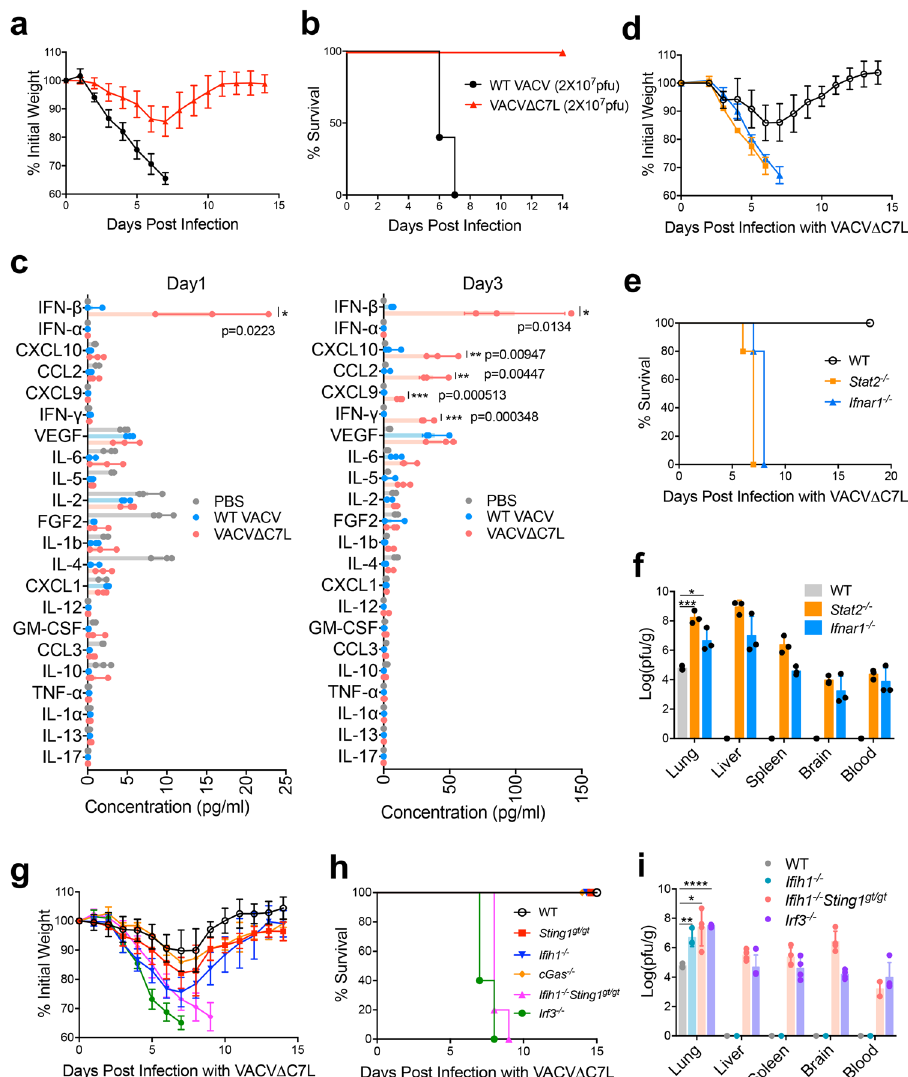
Fig. 1 Type I IFN signaling is essential for restricting replication and dissemination of vaccinia virus and C7 protein is a virulence factor for lethal infection. a , b shown are the percentages of initial weight a or Kaplan – Meier survival curve b of WT C57BL/6J control mice ( n = 5 in each group) over days post intranasal infection with WT VACV or VACV Δ C7L at a dose of 2×10 7 pfu. c Levels of IFN- β and other cytokines/chemokines in BAL from VACV Δ C7L or WT VACV (2×10 7 pfu)-infected mice collected at day1 and day 3 post infection determined by ELISA or Luminex. d , e shown are percentages of initial weight d or Kaplan-Meier survival curve e over days post intranasal infection with VACV Δ C7L at a dose of 2×10 7 pfu in Stat2 − / − , Ifnar1 − / − , or age-matched WT C57BL/6J control mice ( n = 5 in each group). f Titers of VACV Δ C7L in the lungs, livers, spleens, brains and blood of Stat2 − / − , Ifnar1 − / − , or age-matched WT C57BL/6J control mice at day 4 post intranasal infection with VACV Δ C7L at a dose of 2×10 7 pfu. Data are represented as mean±SD ( n = 3 – 5). * p = 0.0148, *** p = 0.000203. g , h shown are the percentages of initial weight g or Kaplan – Meier survival curve h over days post intranasal infection with VACV Δ C7L at a dose of 2×10 7 pfu in cGas − / − , Sting gt/gt , I fi h1 − / − , I fi h1 − / − Sting1 gt/gt , Irf3 − / − , or age-matched WT C57BL/6J control mice ( n = 5 in each group). i Titers of VACV Δ C7L in the lungs, livers, spleens, brain and blood of I fi h1 − / − , I fi h1 − / − Sting1 gt/gt , Irf3 − / − , or age-matched WT C57BL/6J control mice at day 4 post intranasal infection with VACV Δ C7L at a dose of 2×10 7 pfu. * p = 0.0166, ** p = 0.0056, **** p = 0.0000008. Data are presented as mean±SD ( n = 3-5). * p <0.05, ** p < 0.01, *** p <0.001 and **** p <0.0001. Two-tailed unpaired Student ’ s t test was used for comparisons of two groups in the studies. Data are representative of two ( c , f , i ), or three ( a , b , d , e and g , h ) independent experiments. Source data are provided as a Source Data fi